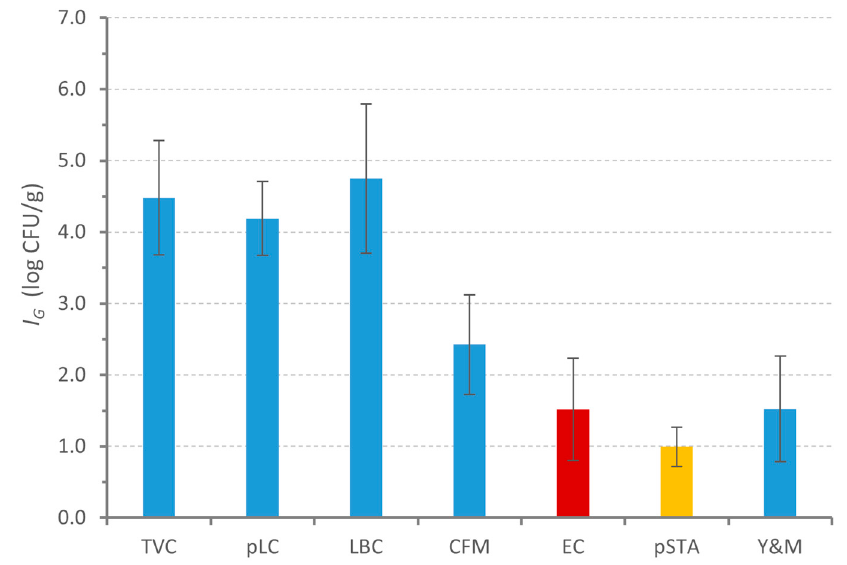
Figure 4. Increase in the counts of microbial indicators (IG) as a result of their growth during 24 h of curd fermentation at 22–23 °C.